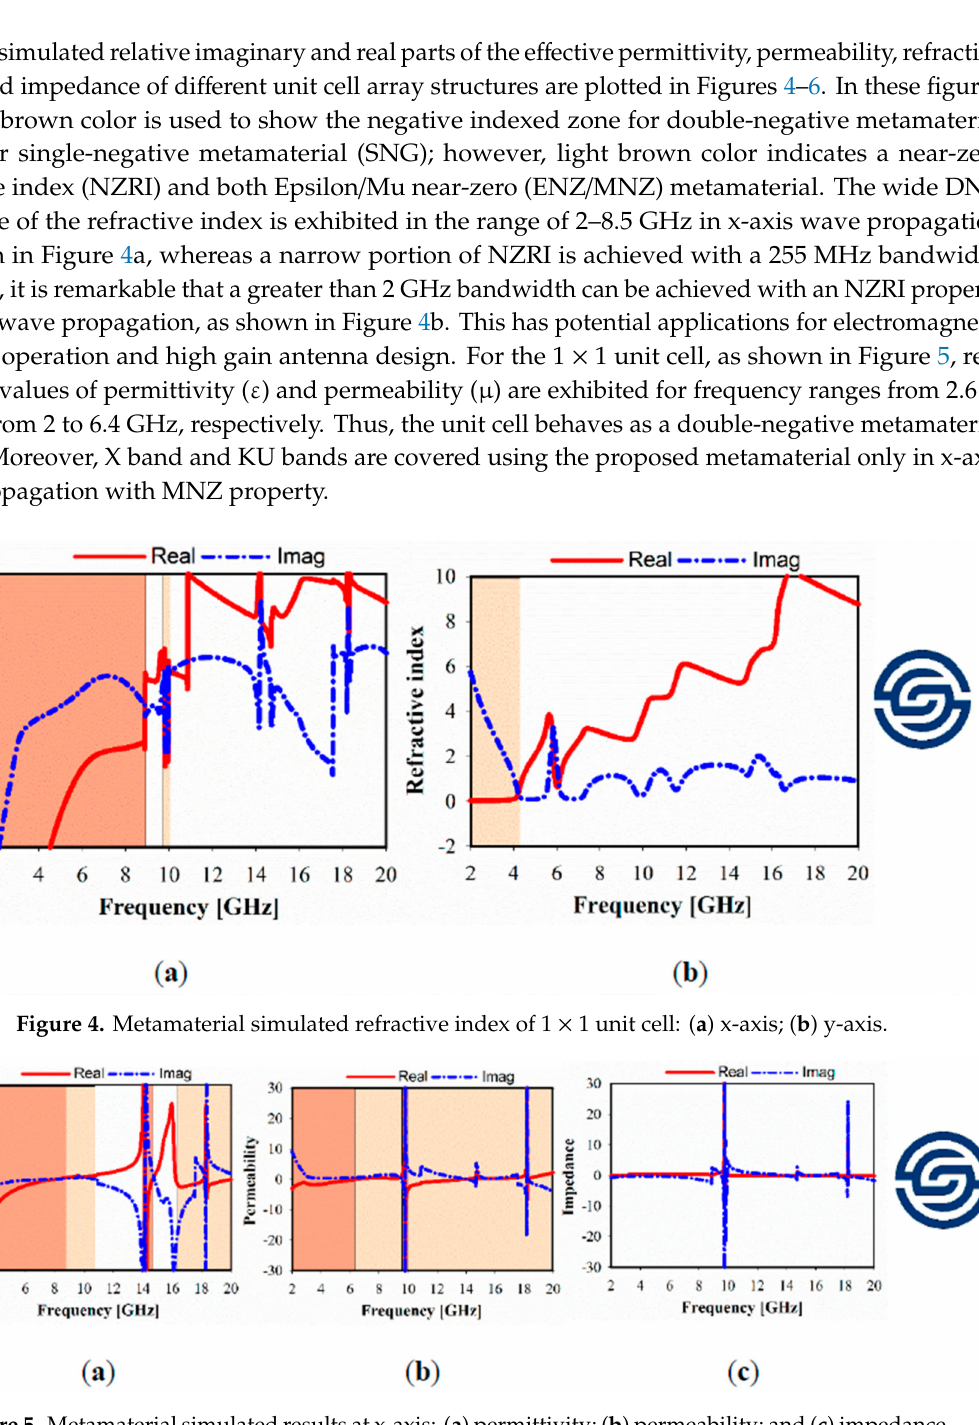
Figure 5. Metamaterial simulated results at x-axis: ( a ) permittivity; ( b ) permeability; and ( c )